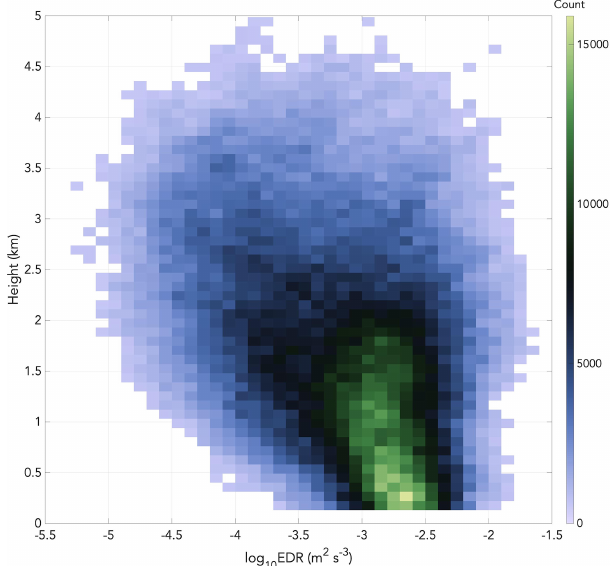
Figure 7. For all 13 COMBLE cases, (a) the relative frequency of liquid water path (LWP) in bins of width 0.1kgm − 2 ; (b) the median, 25th, and 75th percentile of the maximum Doppler veloc- ity ( V D ) in the atmospheric column for each LWP bin of width 0.25kgm − 2 or 0.5kgm − 2 ; (c) the median, 25th, and 75th per- centile of the sum of the vertical air velocity ( V AIR ) in the updraft depth for each LWP bin of 0.25 or 0.5kgm − 2 ; and (d) the median, 25th, and 75th percentile of the maximum V AIR in the updraft depth for each LWP bin of width 0.25 or 0.5kgm − 2